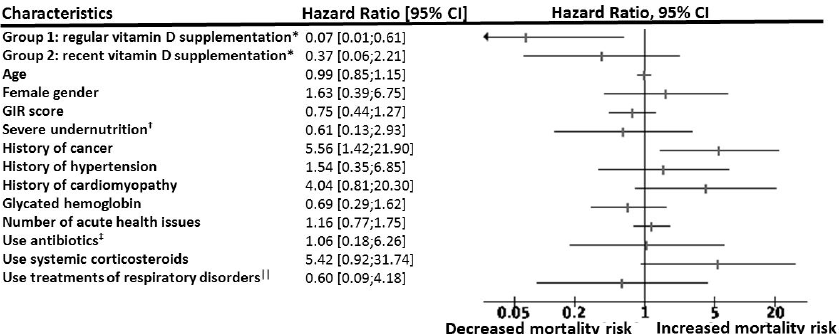
Figure 1. Hazard ratio for 14-day mortality according to vitamin D interventions among participants with COVID-19, adjusted for potential confounders ( n = 77). CI: confidence interval; COVID-19: